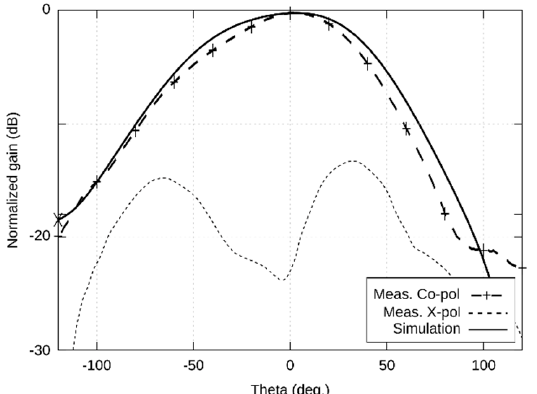
Figure 2. Simulated and measured frequency responses of reflection coefficient at the input of the antenna designed for the 5.8 GHz ISM band.